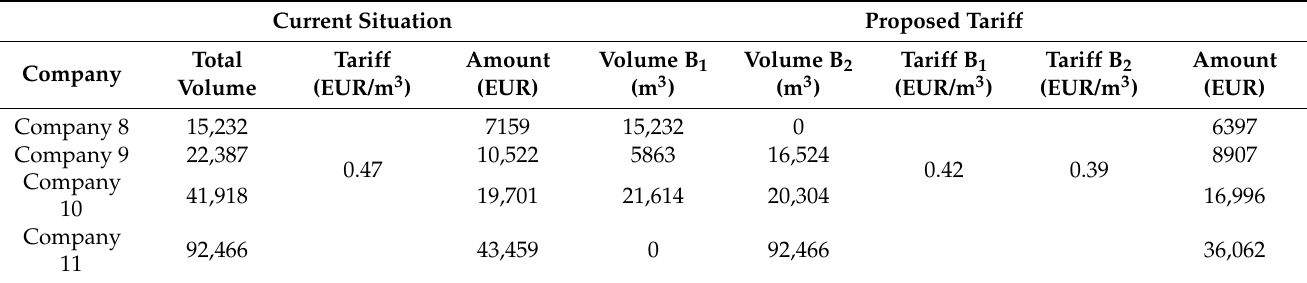
Table 13. Results for sector 3: Current situation and proposal for quarterly consumptions.